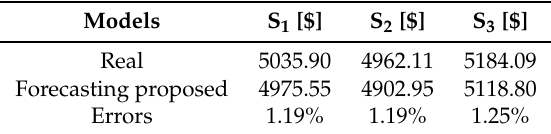
Table 6. Comparison of operating costs.